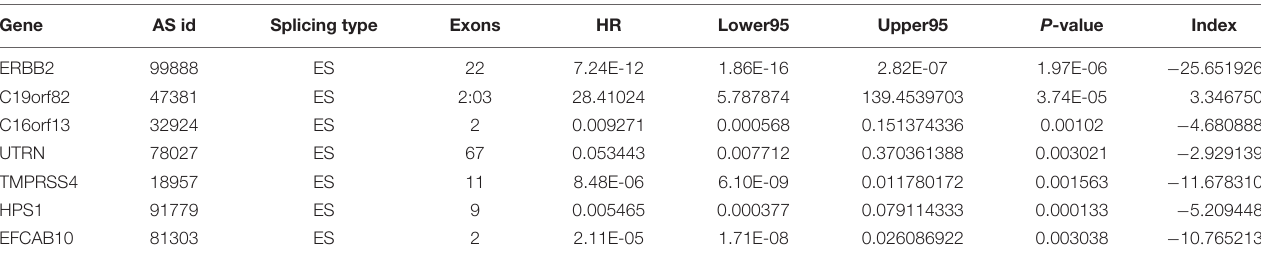
TABLE 2 | Prognostic predictors for esophageal